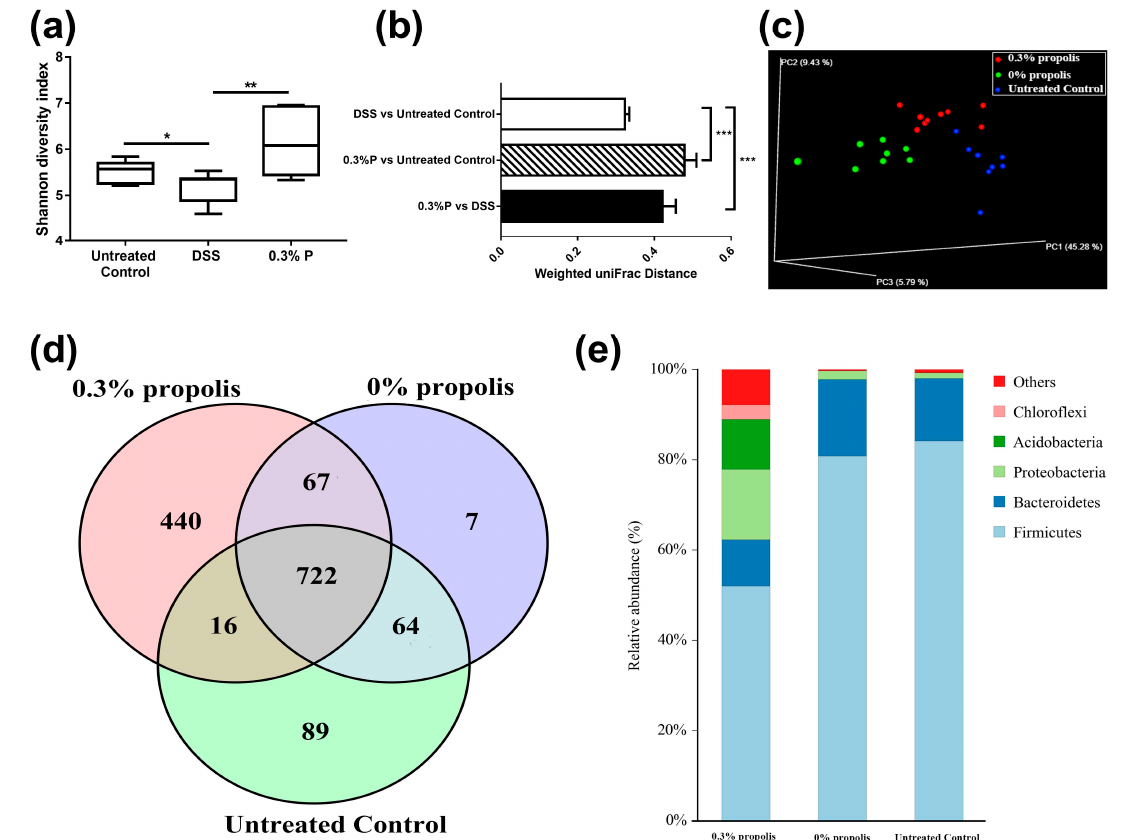
Figure 2. Propolis altered the composition of the intestinal microbiota in colitis rats. Rats’ caecal digesta from untreated control, 0% propolis and 0.3% propolis groups were collected and the intestinal microbiota were examined by 16S rRNA sequencing. ( a ) Alpha diversity was analysed by Shannon diversity index; Data are presented as box plots, n = 8 rats/group; * p < 0.05, and ** p < 0.01 significant difference among two groups; ( b ) Beta diversity between the groups was analysed by weighted UniFrac distance. Data are the mean ± SEM ( n = 8). *** p < 0.001 significant difference among two groups; ( c ) PCoA plot of the gut microbiota based on an unweighted UniFrac metric; ( d ) Venn diagram of OTUs showed microbiota differences between untreated control (green area) and 0% propolis (red area) and between 0.3% propolis (blue area), showing strains altered in these groups, and the overlap among them; and ( e ) relative abundance of predominant bacteria at the phylum level. Data are presented as a staked bar chart, n = 8 per group.